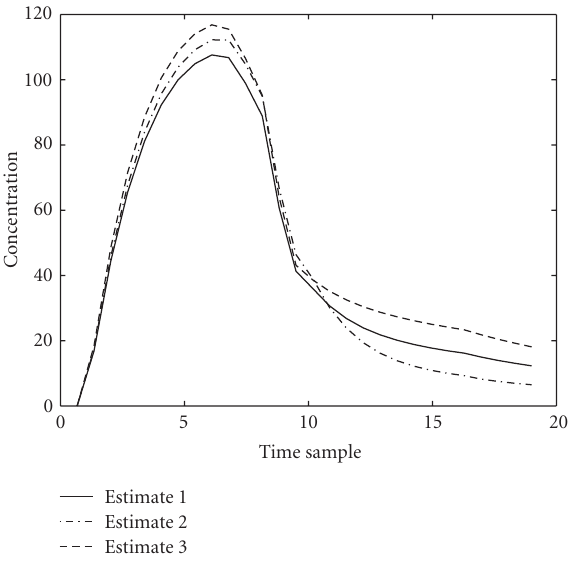
Figure 5: Three compartments used to model the transfer of the tracer between physical compartments and chemical